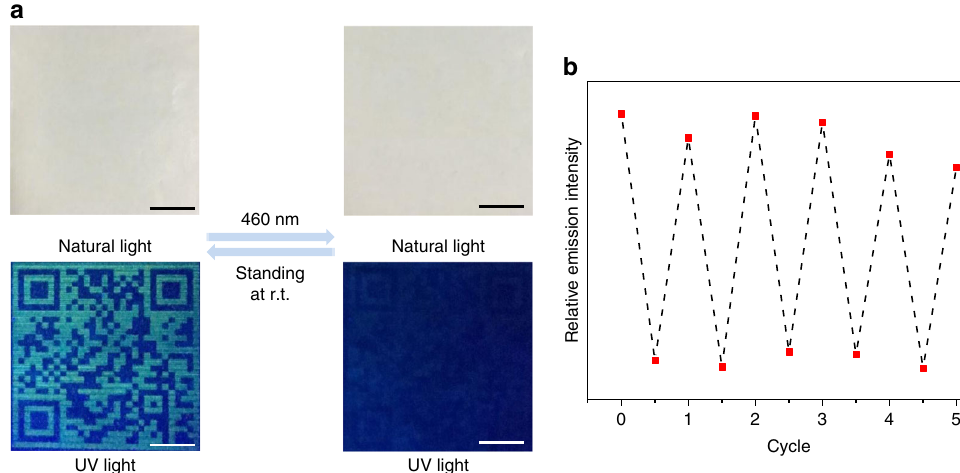
Fig. 8 Single-mode anti-counterfeiting inks from 1 . a Photographs of the fl uorescent QR code (size: 4 × 4 cm on paper) from 1 and its photo- responsiveness. Scale bar: 1 cm. b Relative fl uorescence intensity ( λ = 512 nm) for the QR code as a function of the cyclic numbers